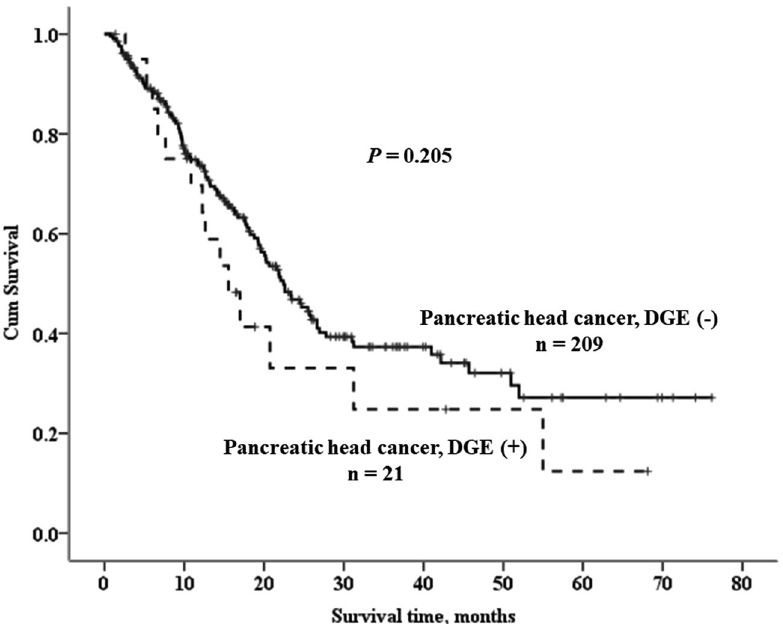
Figure 4. Suvival curves for patients with pancreatic head adenocarcinoma with and without delayed gastric emptying (DGE) after